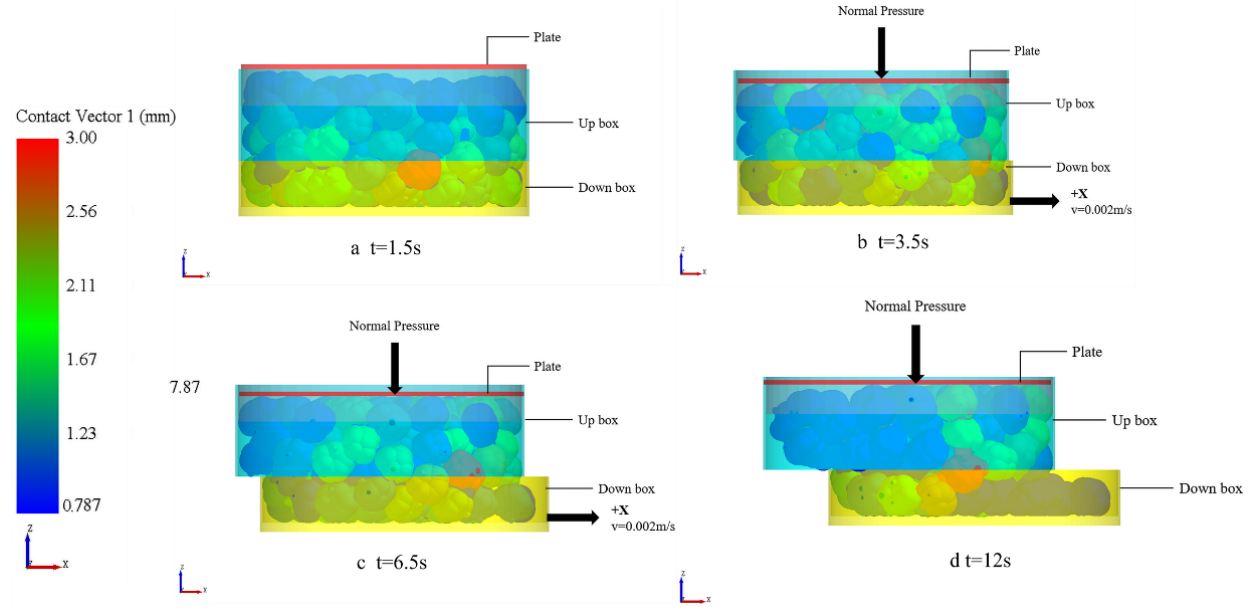
Figure 17. Snapshots of the simulation of the direct shear test of Jinong 1 seeds at different times using the 9-sphere model: ( a ) t = 1.5 s; ( b ) t = 3.5 s; ( c ) t = 6.5 s; and ( d ) t = 12 s. Table 9. Significant analysis of factors in the Plackett–Burman test.